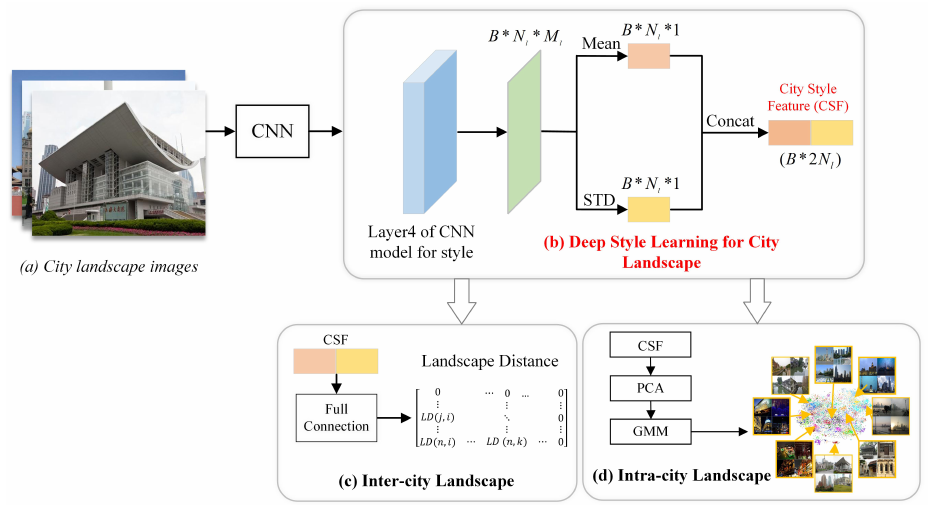
Figure 1. Overall framework. B is short for batch size.